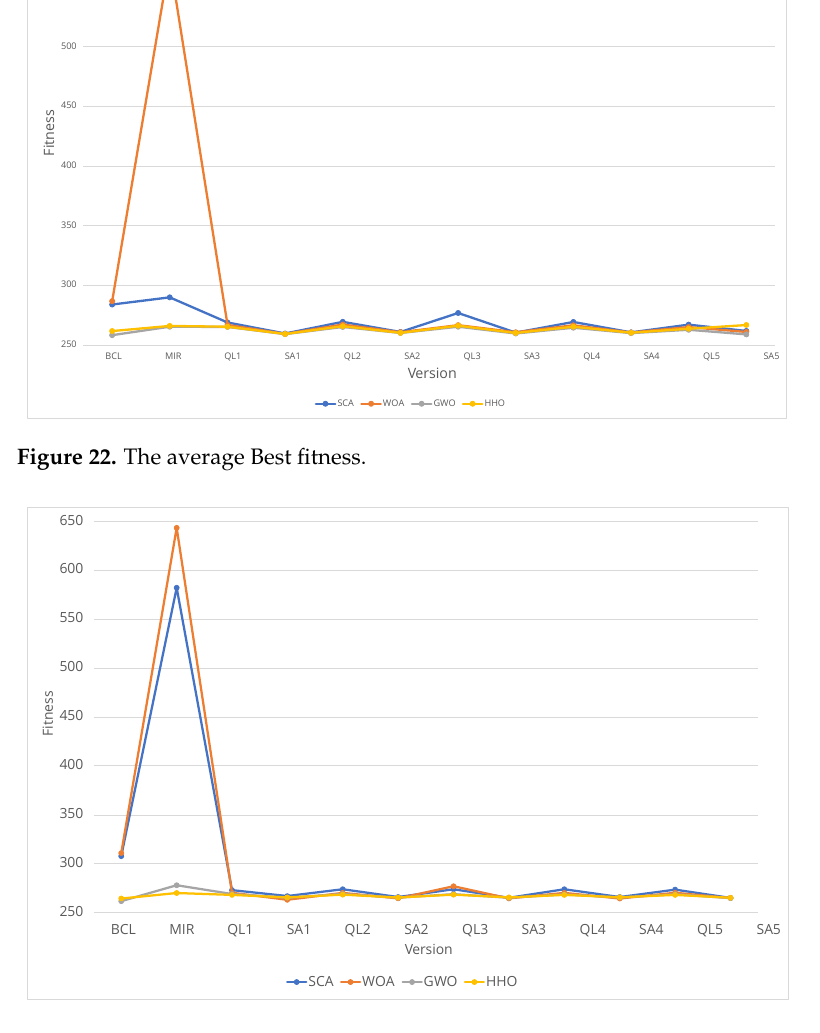
Figure 23. The average Avg